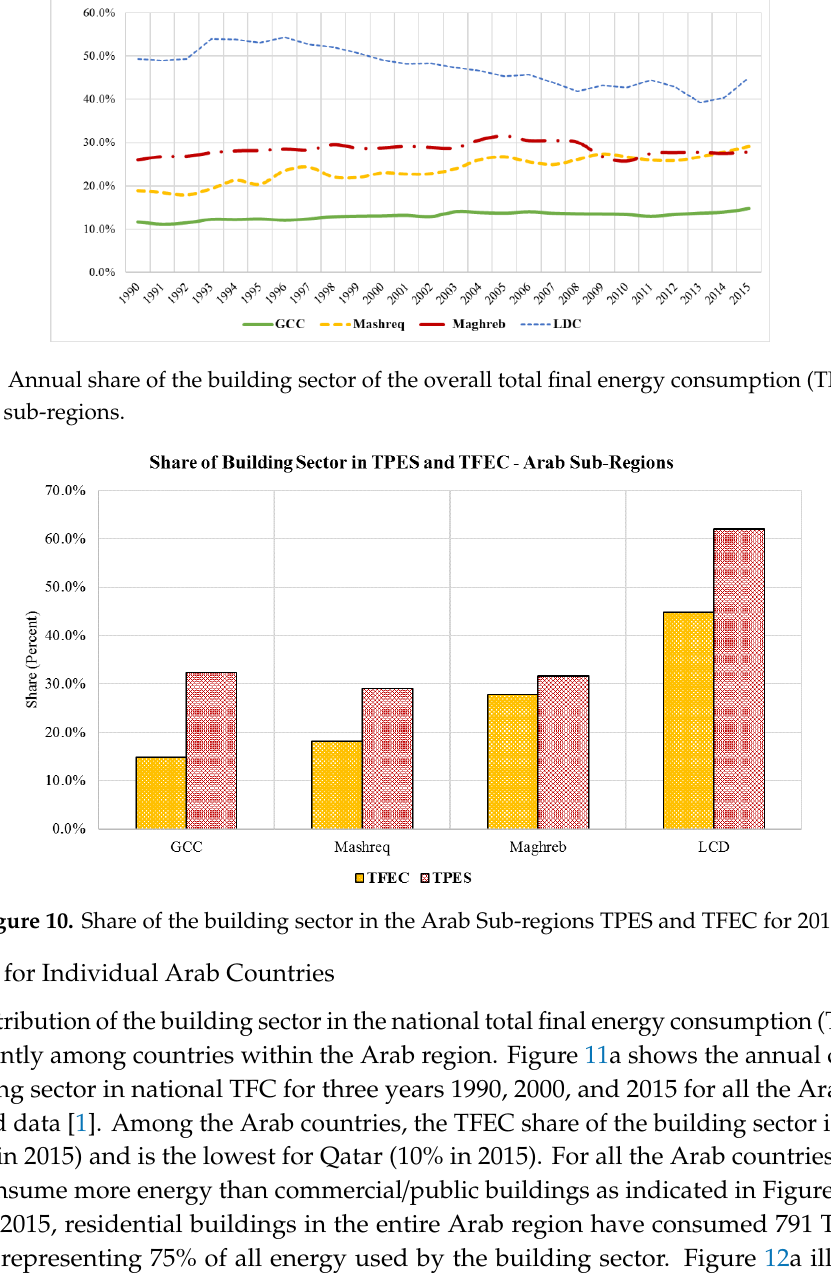
Figure 9. Annual share of the building sector of the overall total final energy consumption (TFEC) for the Arab sub-regions.